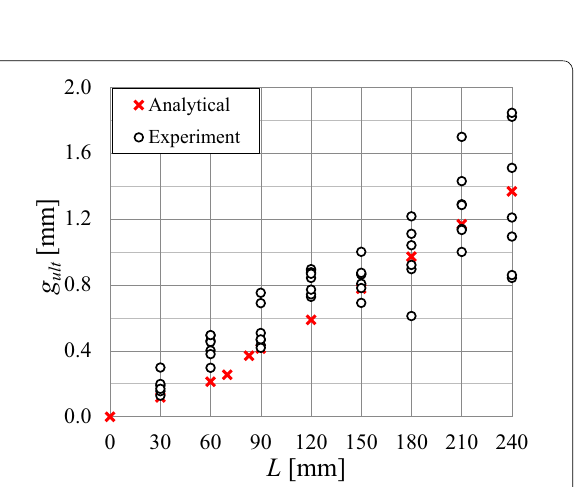
Fig. 8 Load responses of single-lap shear specimens with LD fibers and bonded length L 240 mm. All specimens failed due to fiber = rupture